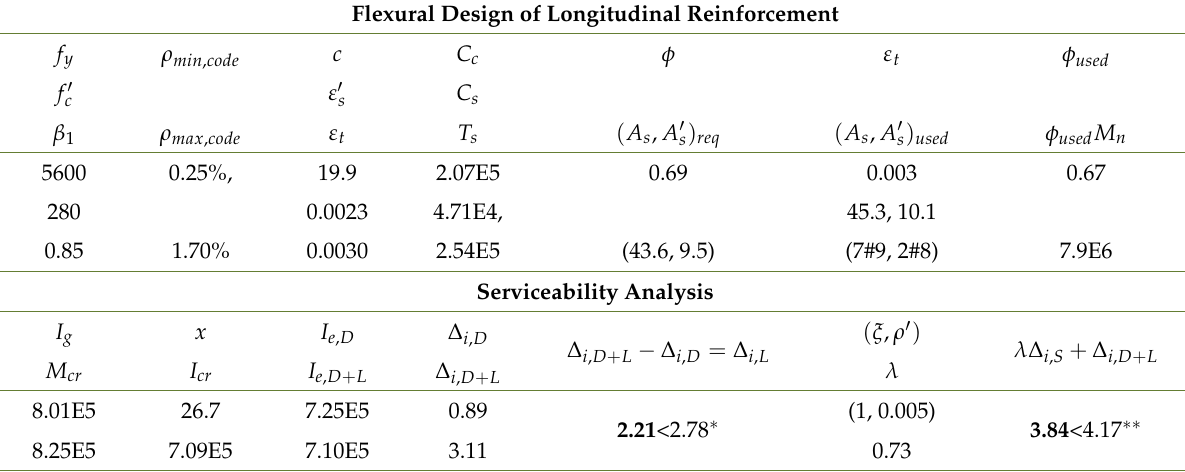
Table 5. Flexural design and serviceability analysis with f y = 5,600 kgf/cm